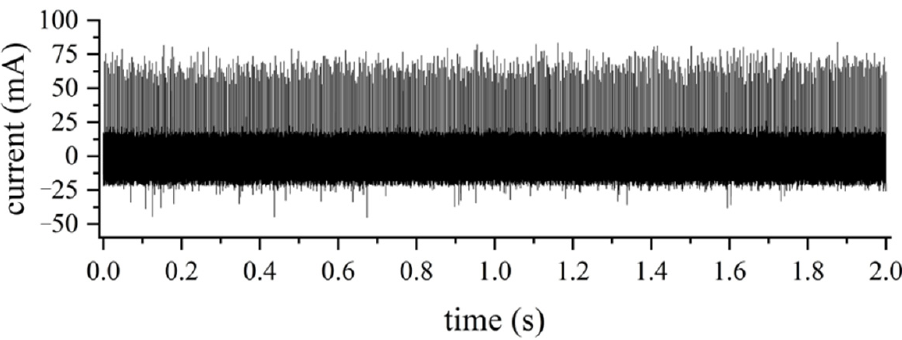
Figure 3. Measurement result of repetitive corona discharge on blade tip of static wind turbine. However, every time when the blade tip rotated to the area below the HV electrode, the corona pulse discharge formed as the E-field on blade tip got stronger than the corona initiation field, thus forming a periodic discharge pattern. Moreover, the periodic sound of corona discharge was audible as the WT rotated. The measured periodic corona discharge signals from the rotating blades were obtained when the linear velocity of the blade tip was controlled at 3 m/s, as shown in Figure 4. As indicated in Figure 4, the corona discharge at the blade tip during the rotation of the WT was characterized by periodic clusters of discharge pulses. Every 3 pulse clusters represented one turn of rotation of the impeller, and the total corona discharge Q r for one rotation of the WT can be characterized by integrating 3 consecutive pulse clusters. Considering the symmetry of the three blades, the corona charge at the blade tip during the rotation of a single blade from a 0-degree to a 60-degree angle, with respect to the axis of the tower, was Q r